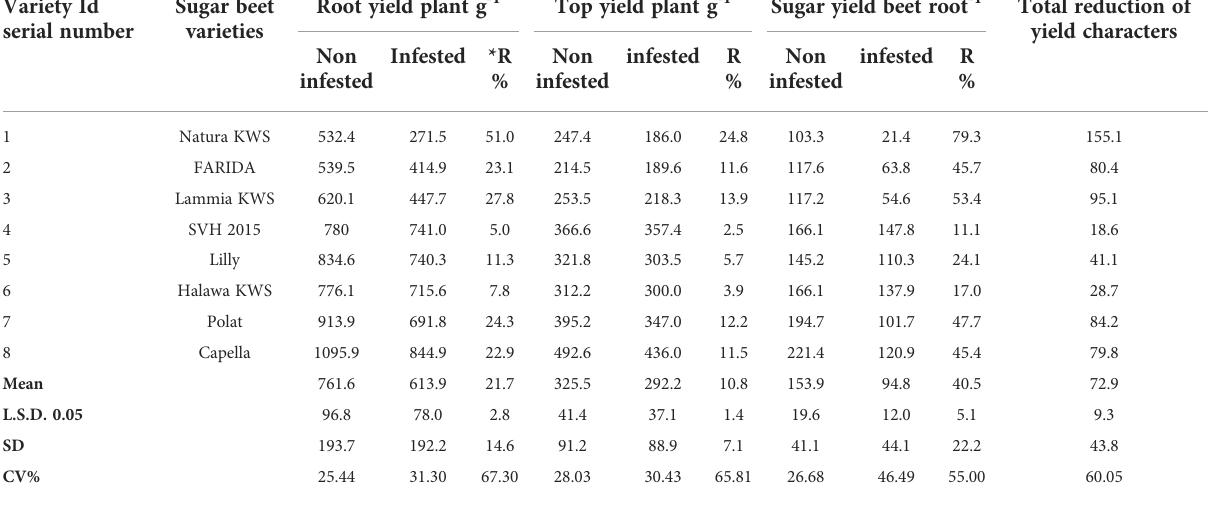
TABLE 5 Root, top, and sugar yields of the screened sugar beet (Beta vulgaris saccharifera) varieties as in fl uenced by the infection of root-knot nematode, Meloidogyne incognita.